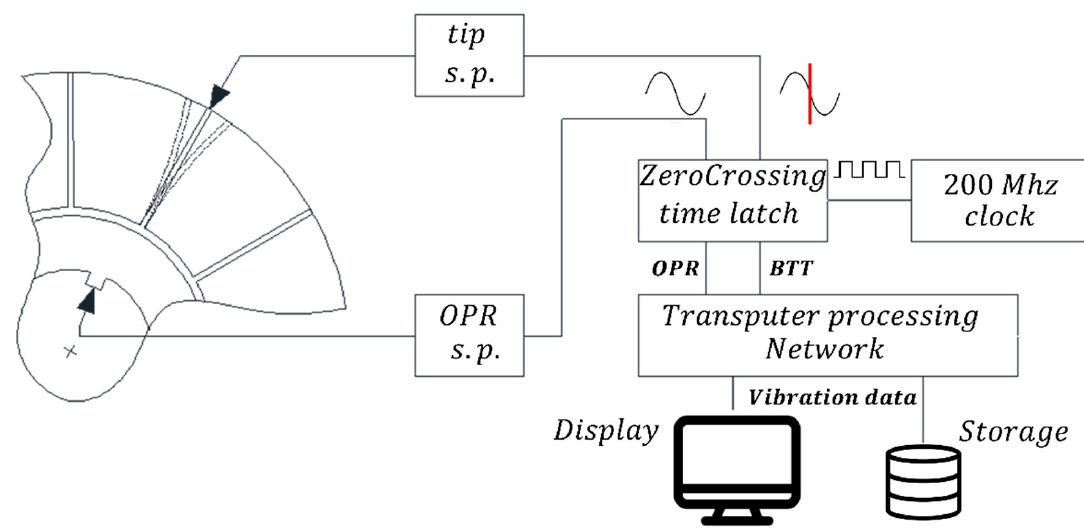
Figure 2. Reproduction of a typical blade tip-timing system (1996) [7].